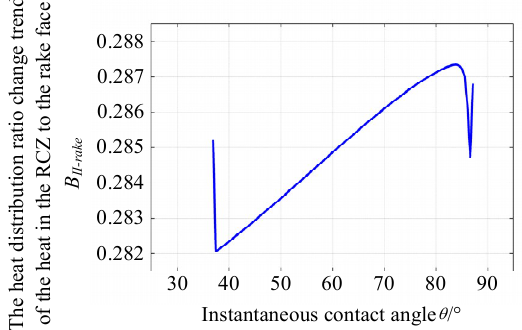
Figure 17. Heat distribution ratio of the heat source to the rake face in the RCZ.